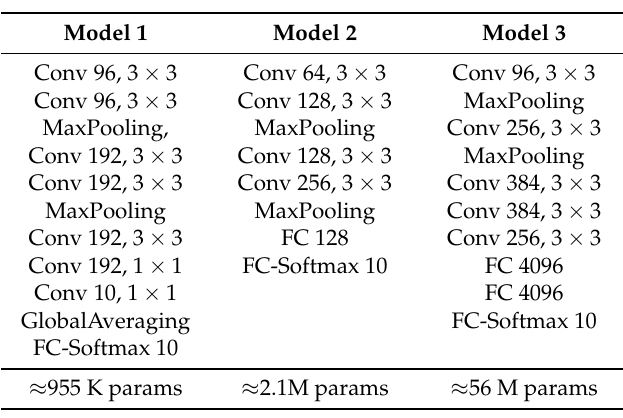
Table 1. Baseline model